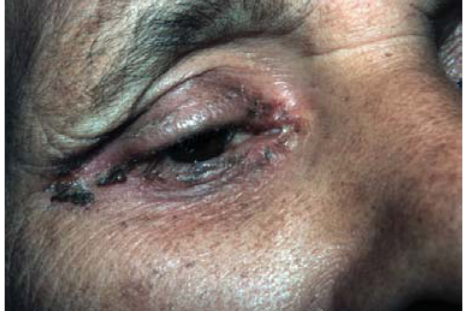
Figure 4 - Erythematous scaling and crusted plaques, with exulceration on the edges of the lesions, involving the periorbital area